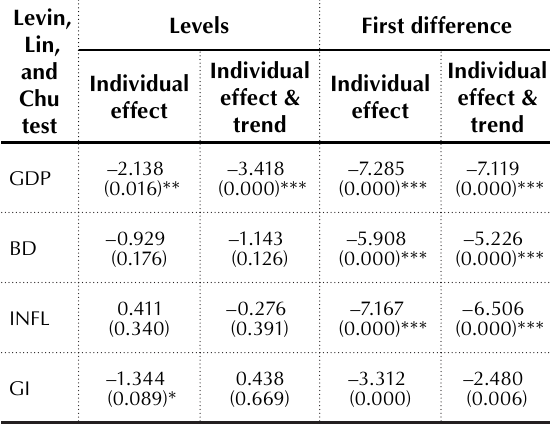
Table 1. Panel unit root results: Levin, Lin,